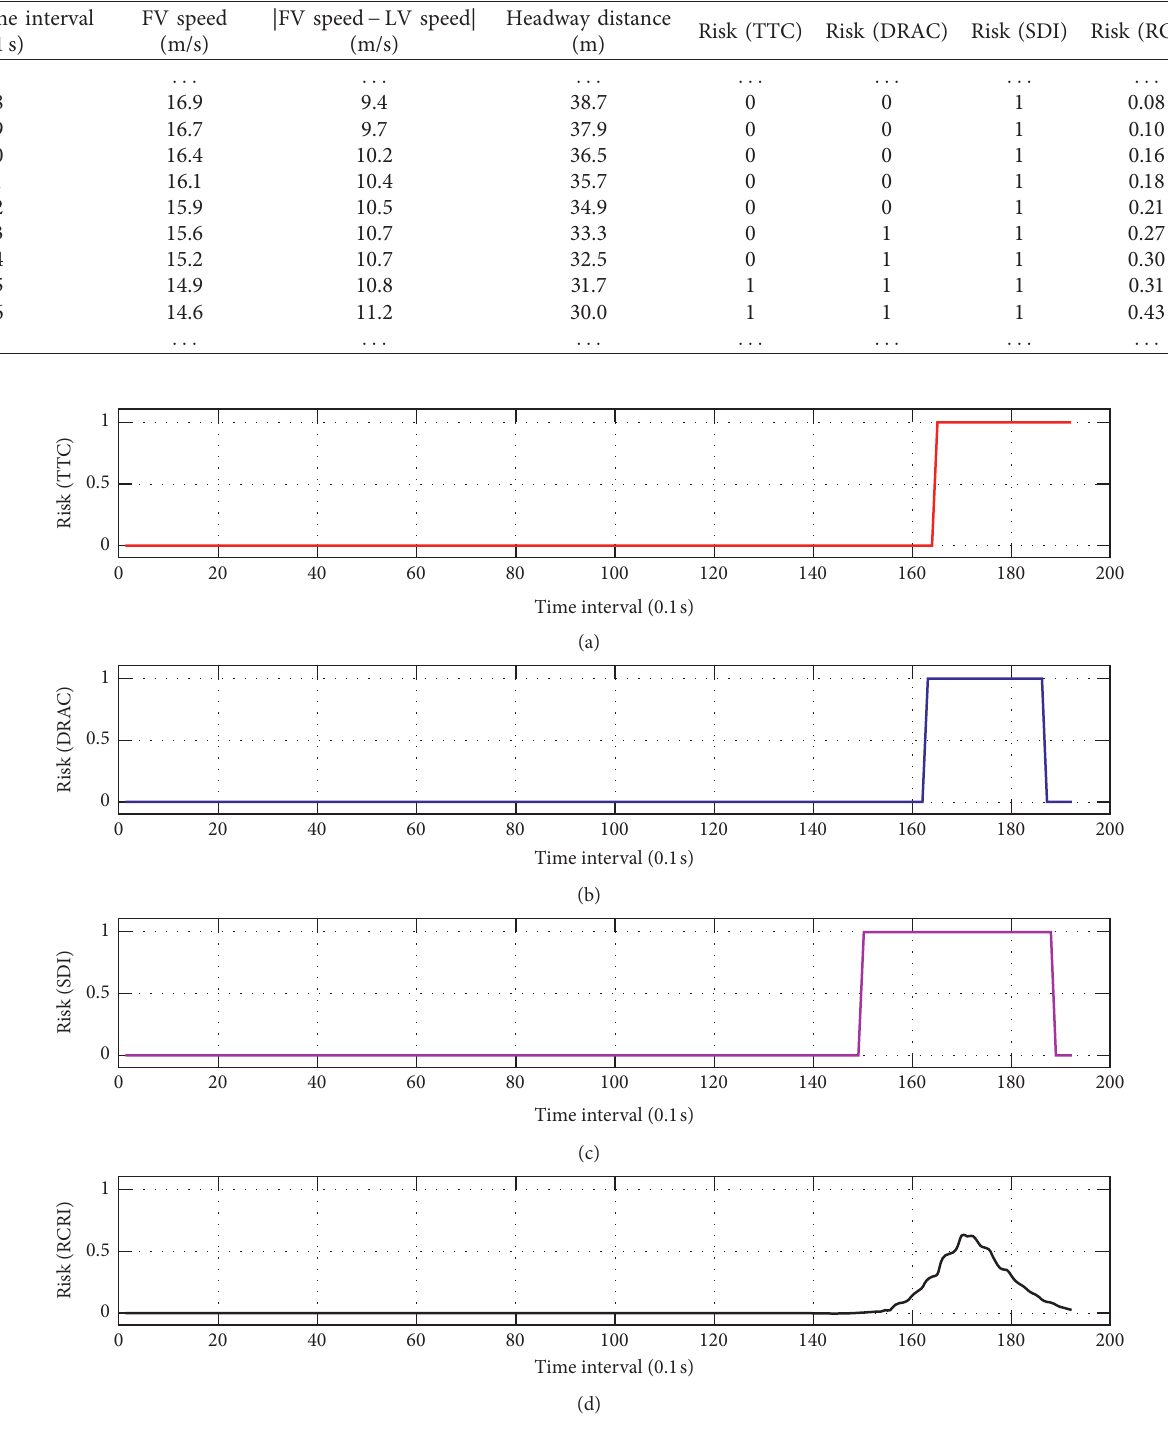
Table 4: The vehicle movement data and risk identification results for one car-following event. Time interval